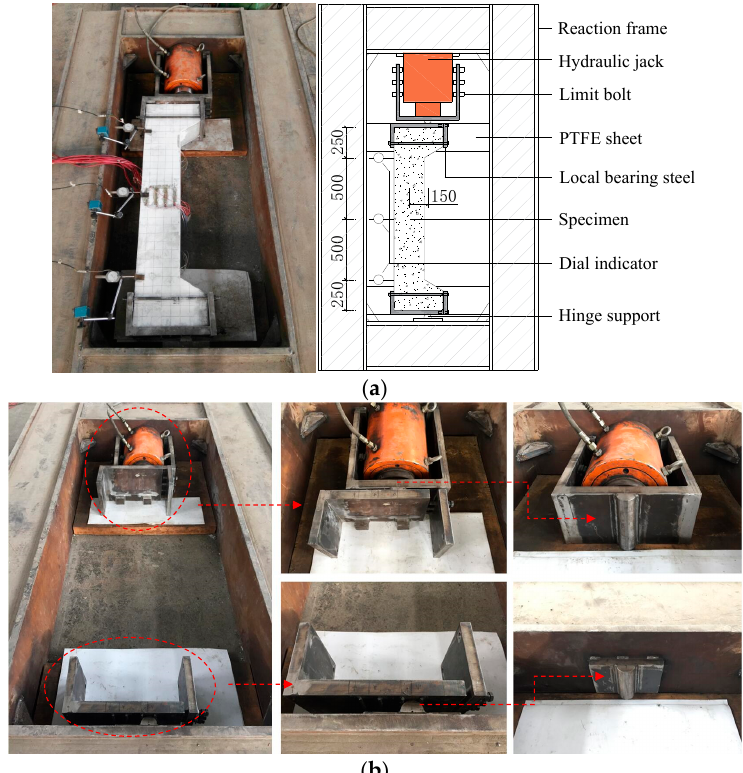
Figure 8. Test setup for eccentric compressive testing: ( a ) Overall view and dimensions (unit: mm), ( b ) details at the two ends of the loading device.